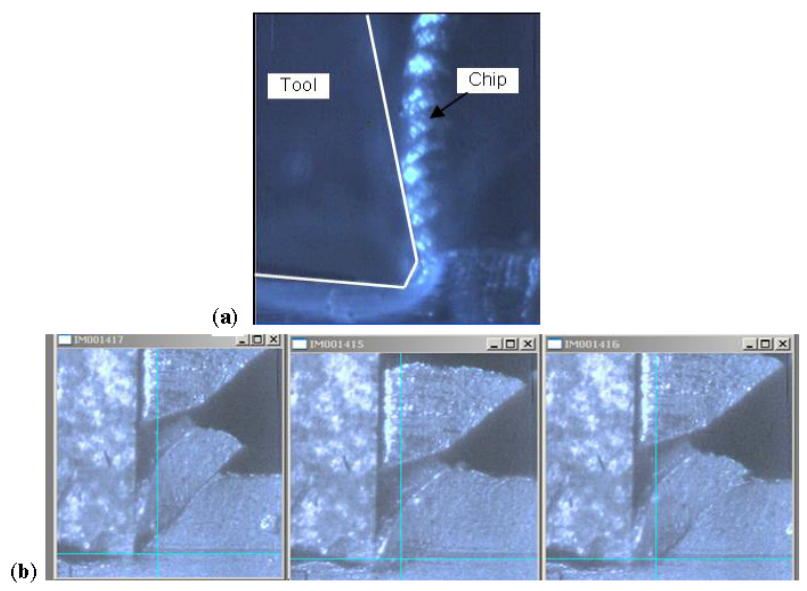
Figure 5. Chip formation; ( a ) morphology, V = 65 m/min, rake angle process, V c